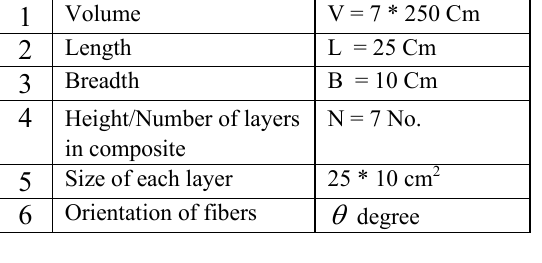
Table 2: Physical and geometrical properties of a composite part